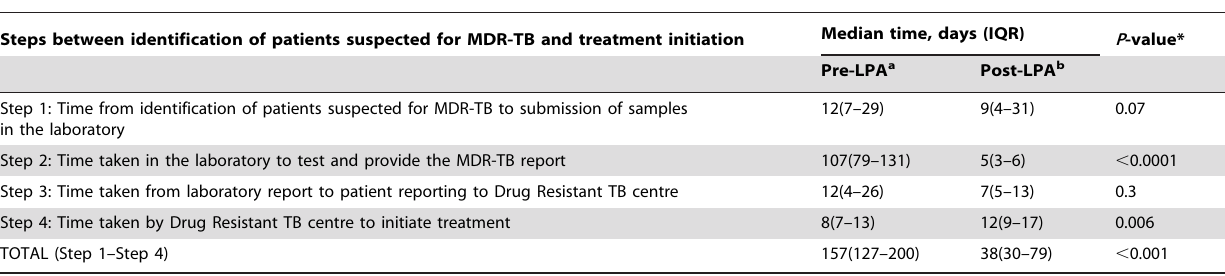
Table 2. Comparison of time from identification of patients suspected for MDR-TB to initiation of MDR-TB treatment between pre- and post-LPA period - New Delhi, India.